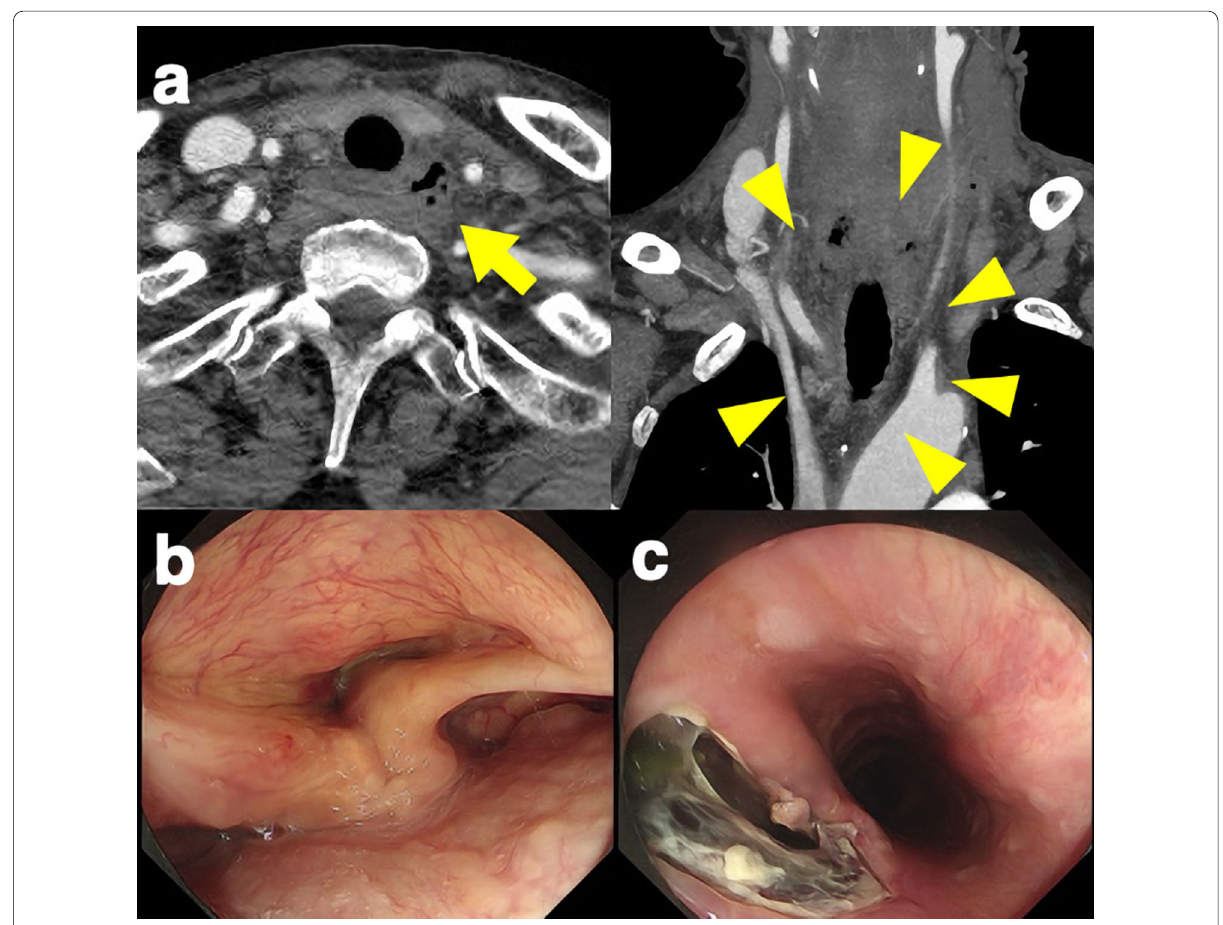
Fig. 2 Examinations on the second day after the injury. CT revealed free gas (yellow arrow) and fluid accumulation (yellow arrowheads) around the thoracic esophagus ( a ). Upper gastrointestinal endoscopy shows left vocal cord palsy ( b ) and injury site on the esophageal wall ( c